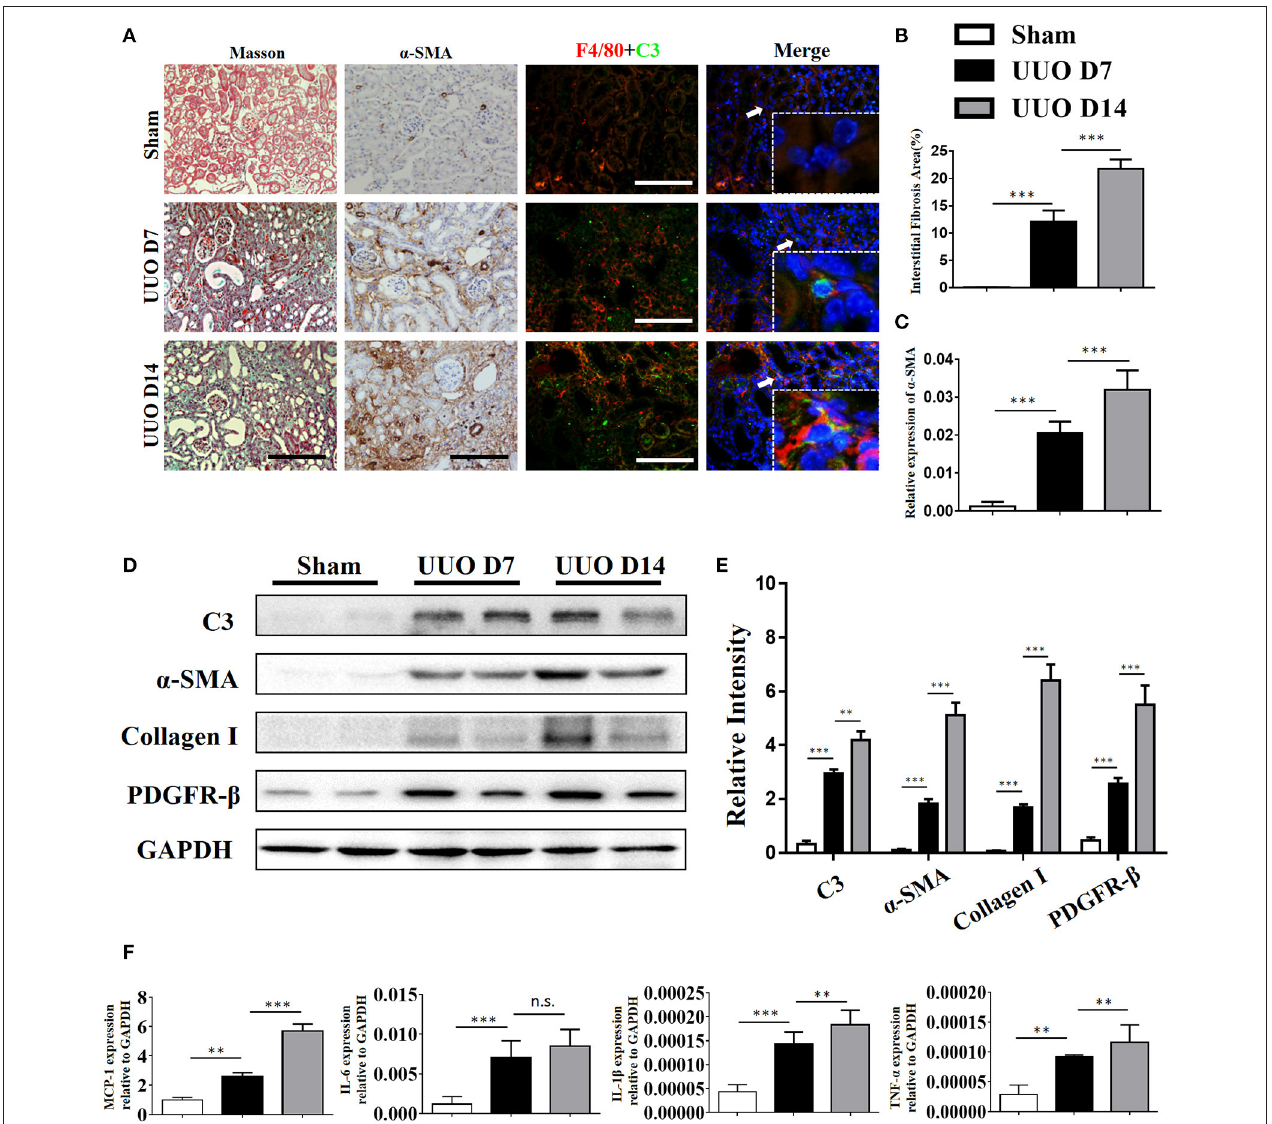
FIGURE 2 | Complement C3 is increased in the obstructed kidney. (A) Masson’s trichrome staining indicates collagen deposition. IHC staining showing α -SMA expression in the sham control and UUO mice; Immunofluorescence staining showing increased C3 (green) expression in UUO kidneys in the interstitium on days 7 and 14 and colocalization (white arrows) with F4/80 (red) original magnification, × 400. Quantitative positive area of interstitial fibrosis (B) and a-SMA (C) positive were shown as mean ± SEM. n = 6 per group, Scale bar, 50 µ m. (D) The expression levels of C3 and fibrotic markers ( α -SMA, PDGFR- β , and Collagen I) were detected by Western blot, and (E) the histogram shows the relative intensity for each marker normalized to GAPDH. n = 6 per group. (F) Real-time PCR showing relative renal mRNA levels of MCP-1, TNF- α , IL-6, and IL-1 β in sham and UUO mice. The error bars represent the SEM. ** P < 0.01; *** P <